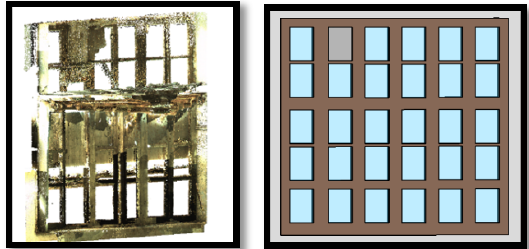
Figure 15: Creating the object library (window).